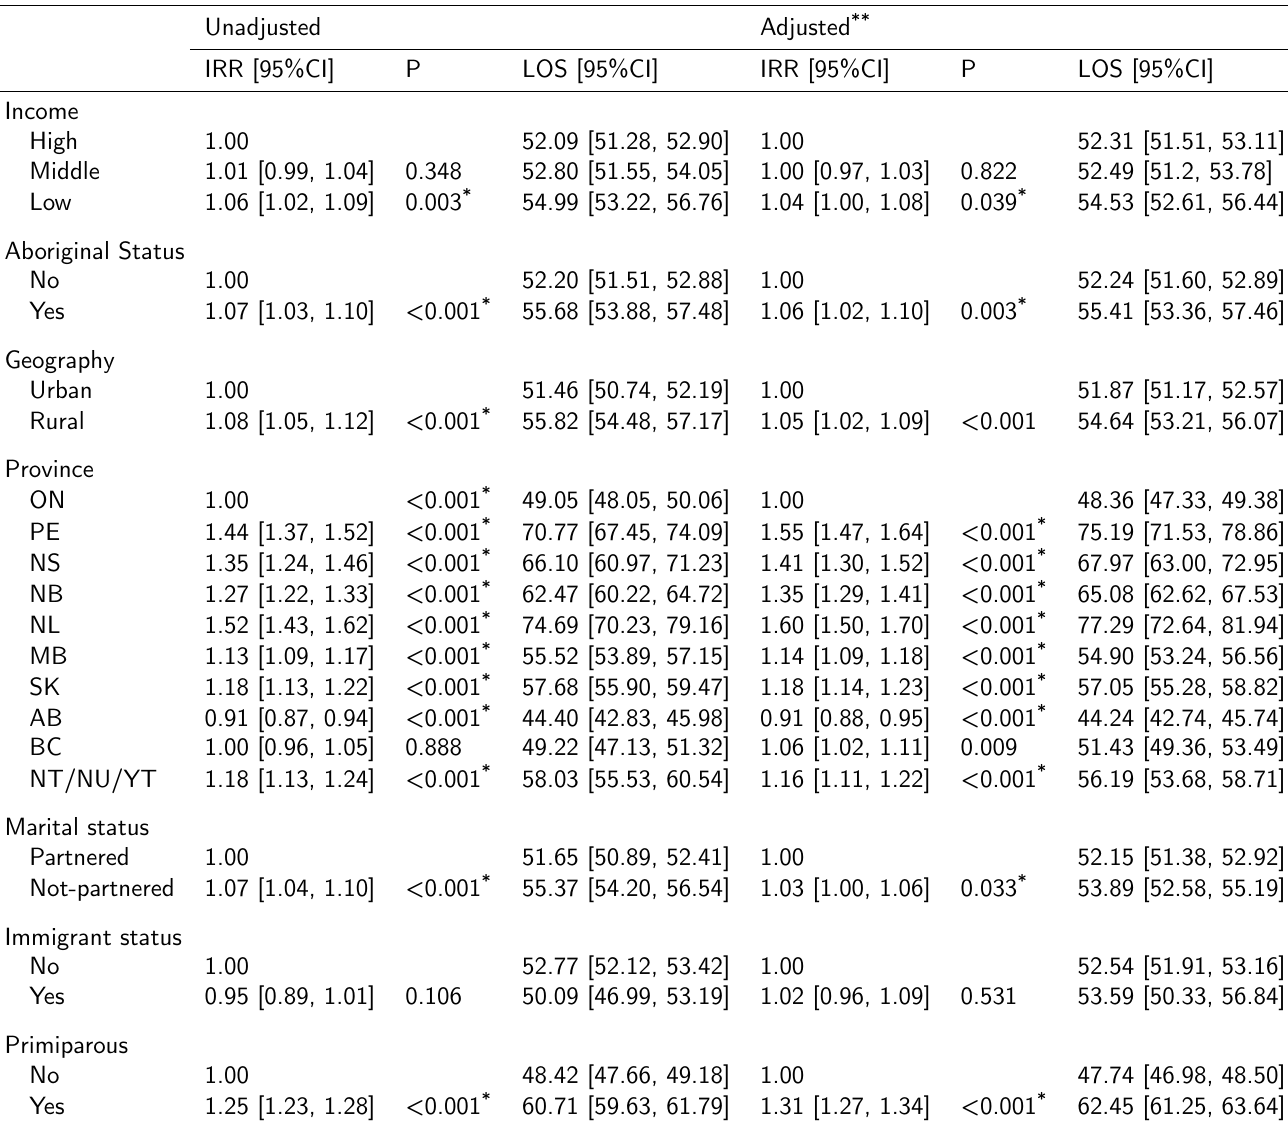
Supplementary Table 4. Incidence rate ratios and marginal estimates of length of stay (LOS) in hours Vaginal Delivery (n = 15,902)